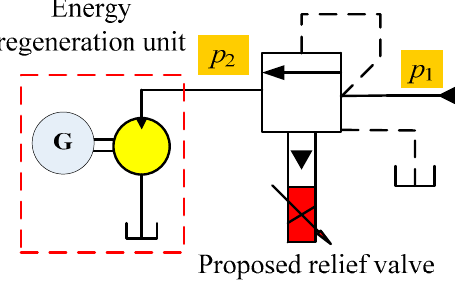
Figure 10. Simplified working principle diagram.